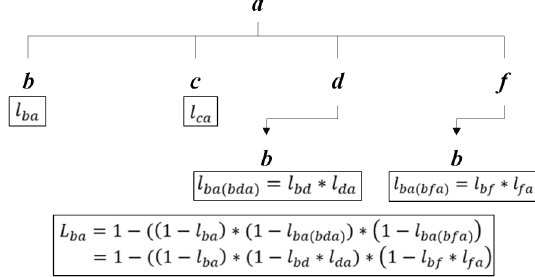
Fig. 3. Combined likelihood algorithm